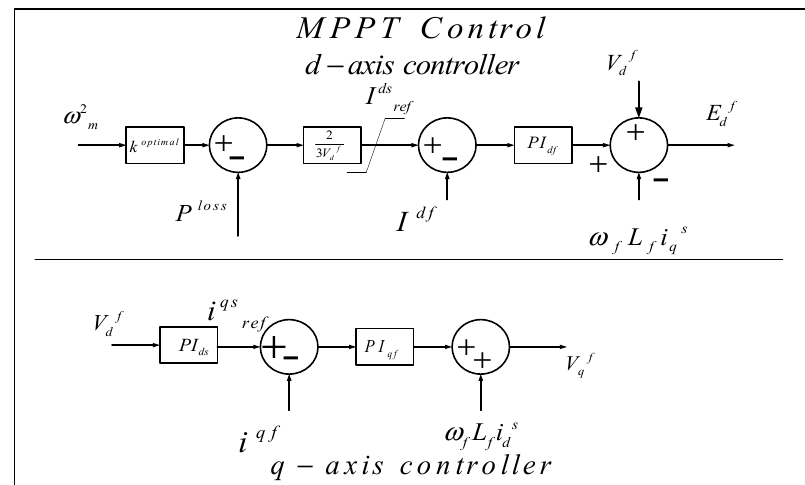
Figure 3. Proposed grid side control.